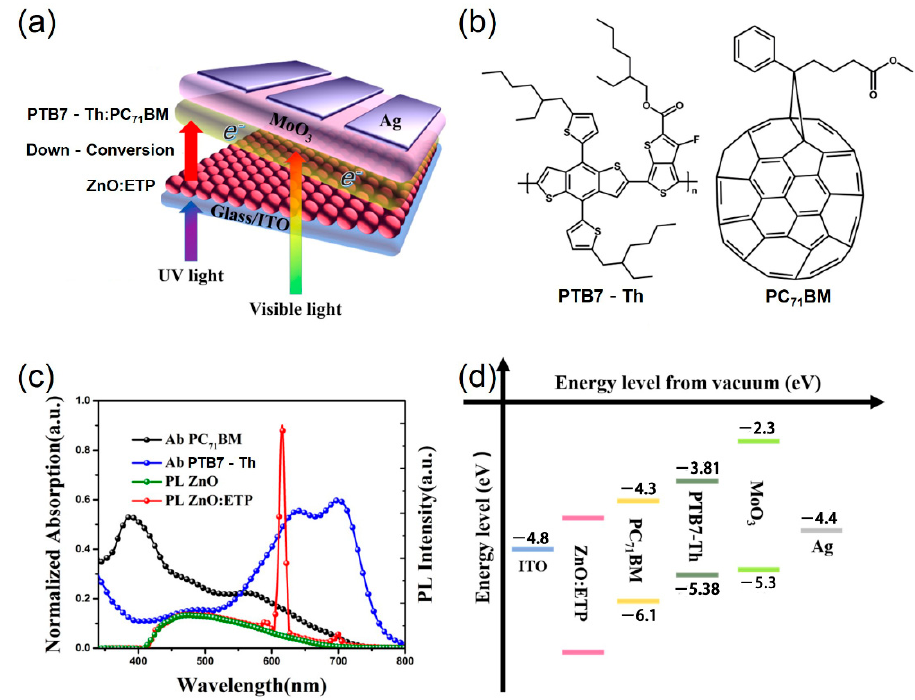
Figure 1. ( a ) Schematic illustration of the device architecture in this work. ( b ) The molecular structure of polymer PTB7-Th and PC 71 BM. ( c ) Absorption spectra of the neat PTB7-Th and PC 71 BM films and photoluminescence (PL) spectra of ZnO and ZnO / Eu(TTA) 3 phen (ETP). ( d ) Energy level diagram of the components of the device.